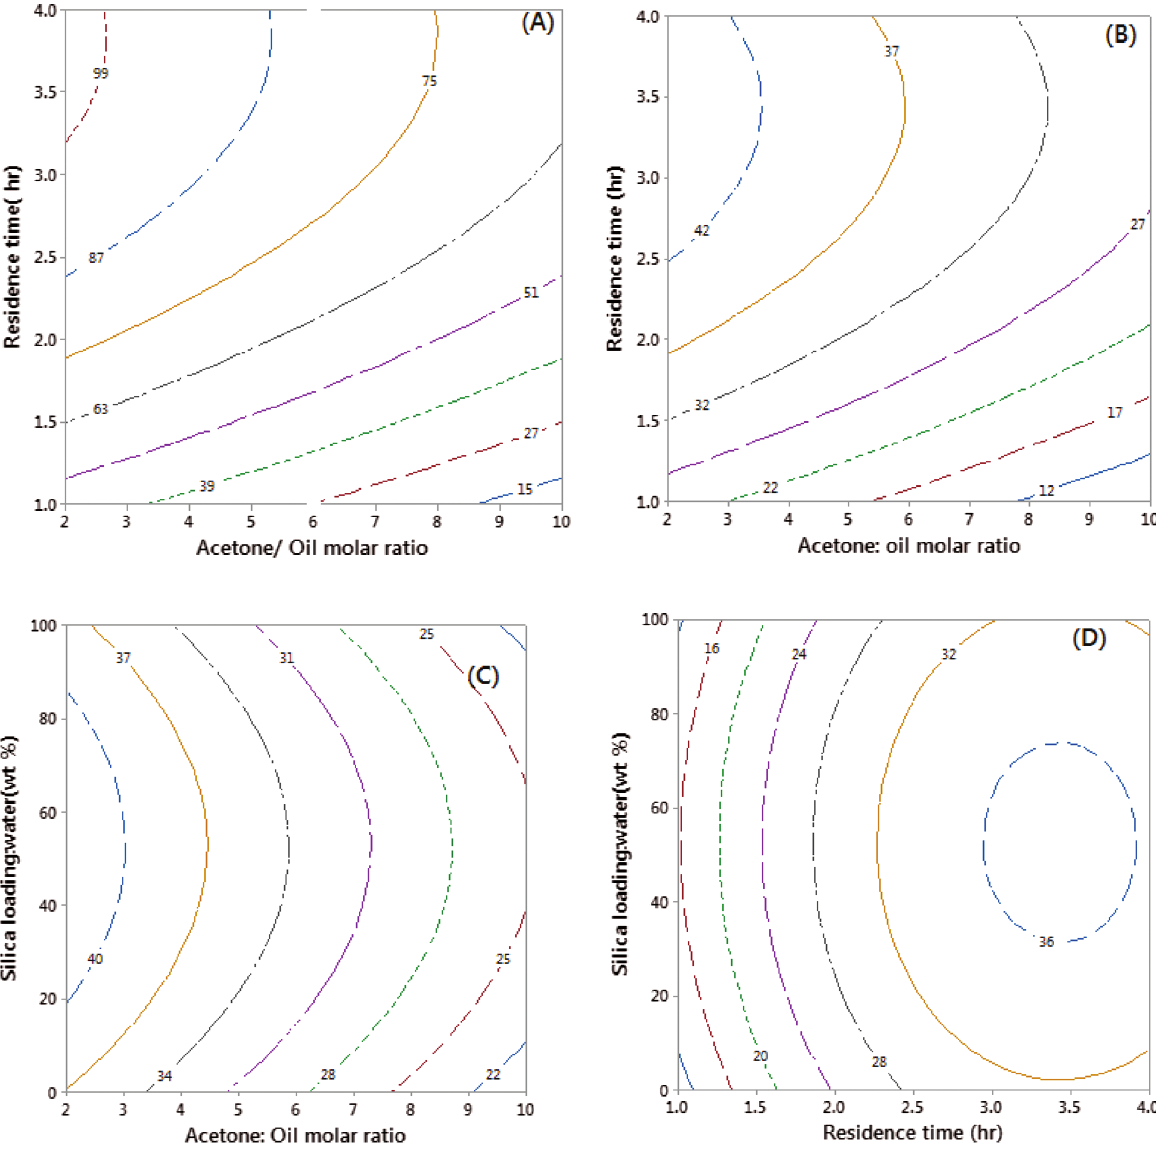
Figure 3: The effects of reaction time and acetone-to-RSO molar ratio on the yields of FAME (a) and solketal (b) for reactions at 50 wt% of silica gel loading / 1 mol RSO; and the effects of silica loading on the solketal yields, at different acetone molar ratios (c), and reaction times